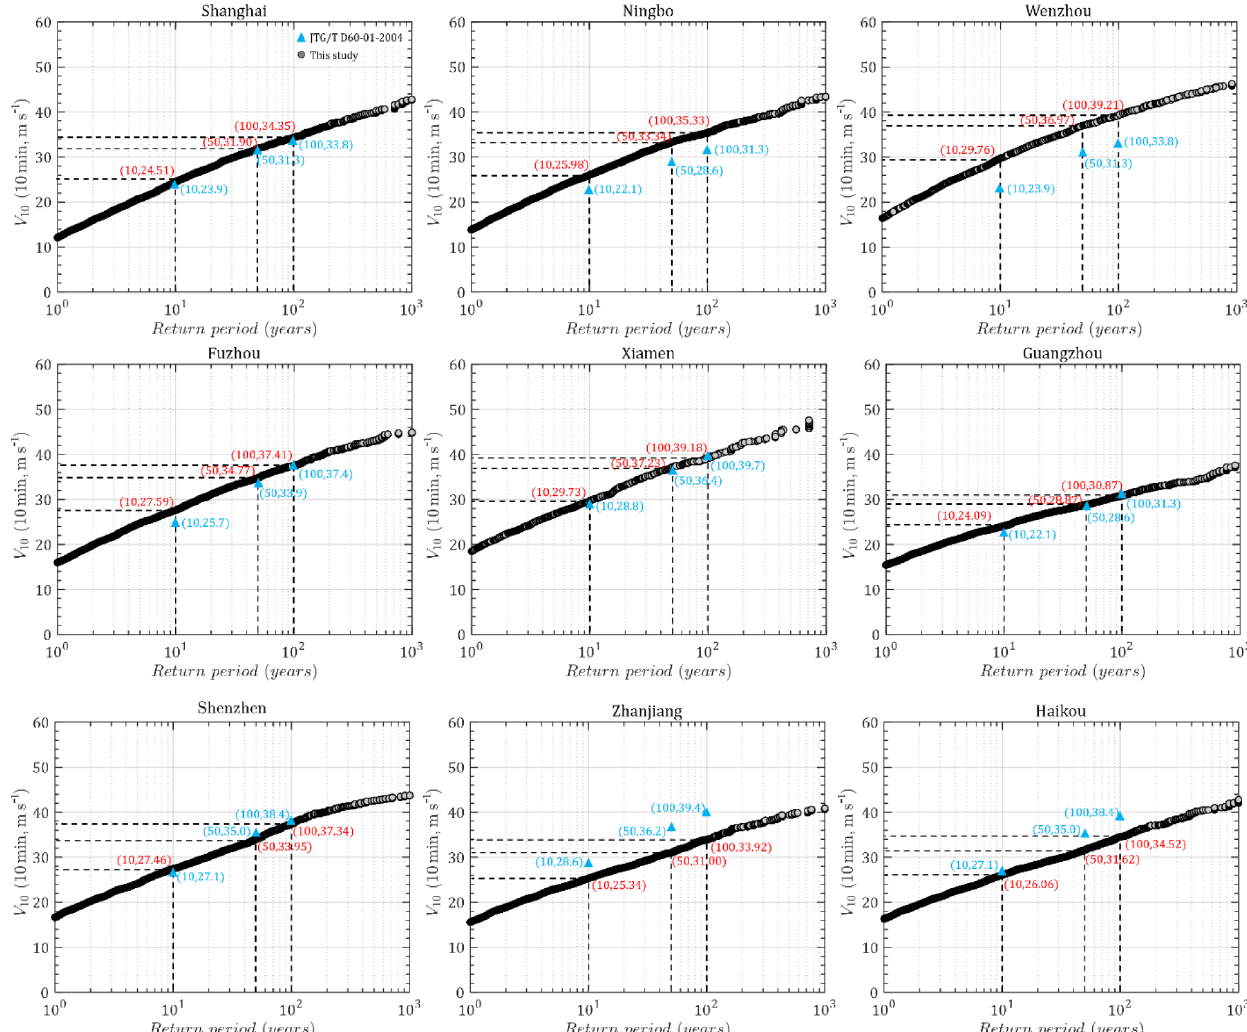
Figure 18. Predicted and code-suggested TC design wind speed versus return period of nine coastal cities in